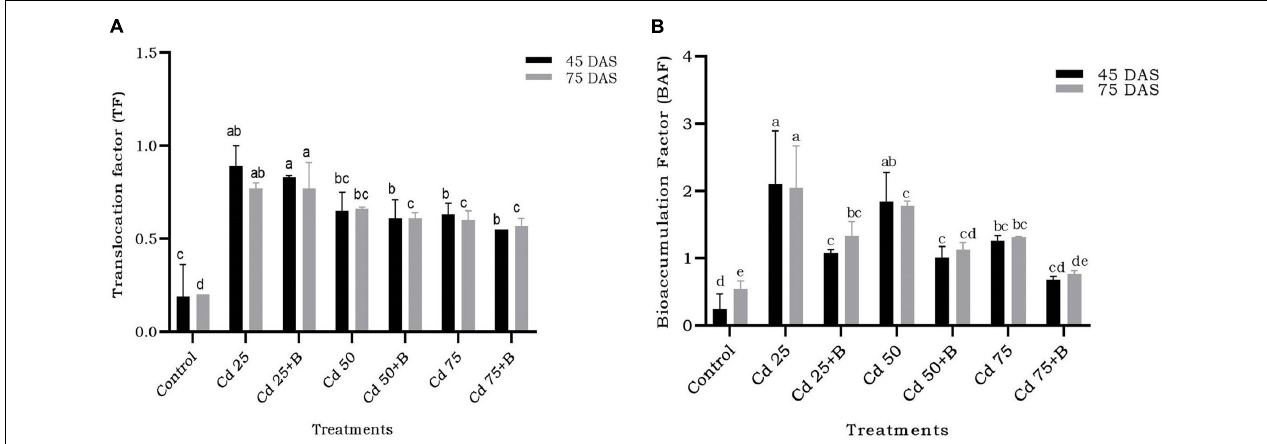
FIGURE 9 | Effect of the application of Ochrobactrum intermedium BB12 on (A) translocation factor and (B) bioaccumulation factor of Cd by spinach plants grown in the soil containing 25 (Cd25), 50 (Cd50), and 75 (Cd75) mg kg − 1 Cd content at 45 and 75 DAS. Values are the means ( ± SD) of three replicates; within the same column with different letters, values are significantly different at p ≤ 0.05 in DMRT. SD, standard deviation. “a” stands for highest variation, followed by “b” and lowest by “e” from the experimental